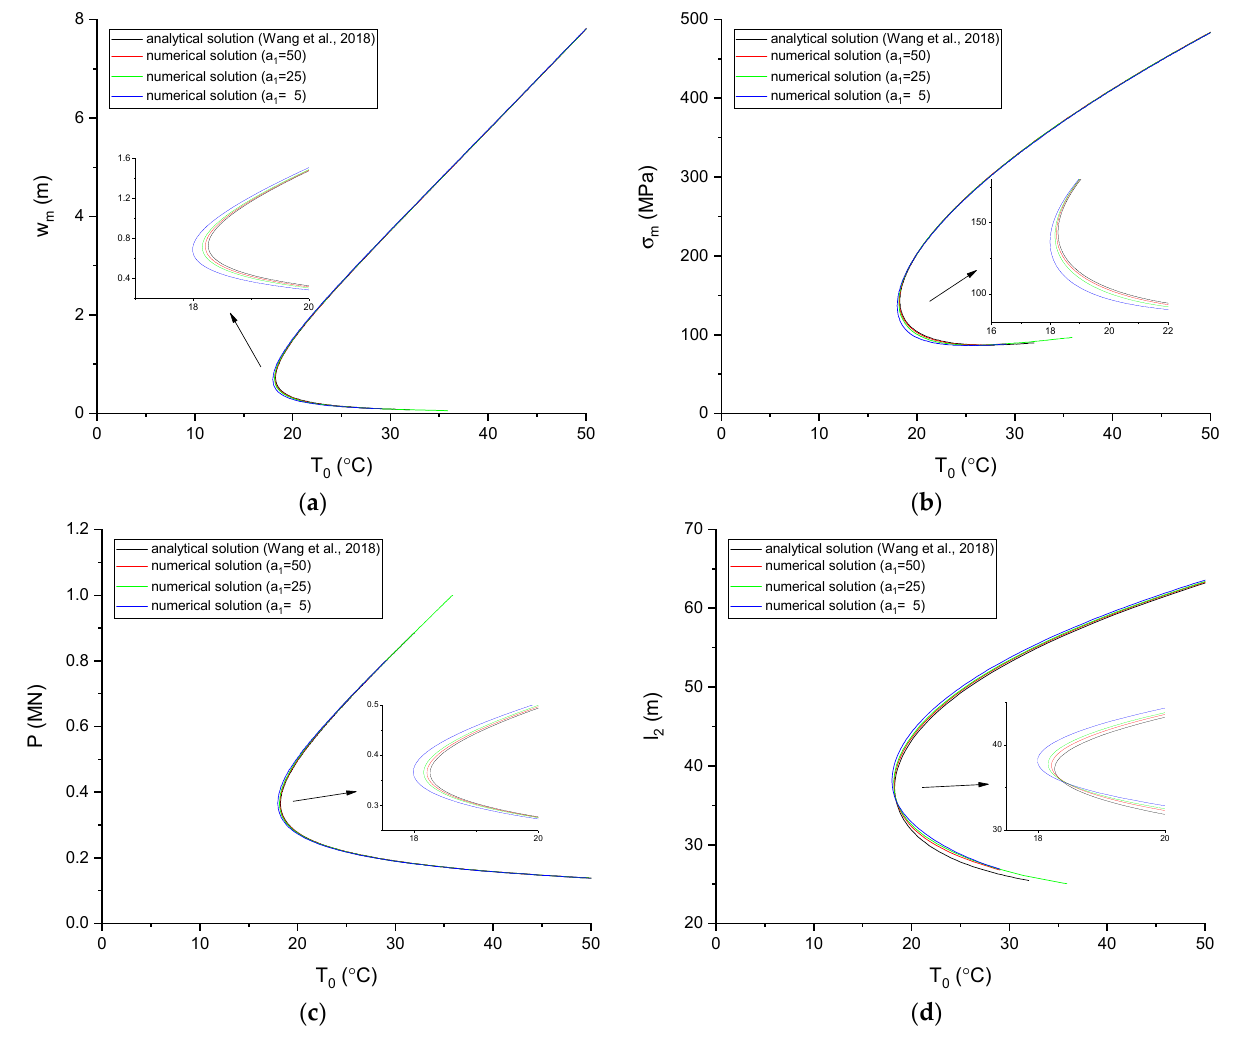
Figure 5. Error analysis. ( a ) w m . ( b ) σ m . ( c ) P . ( d ) l 2 ( µ brk = 0.5, v om = 0.1 m, µ s = 0.1)